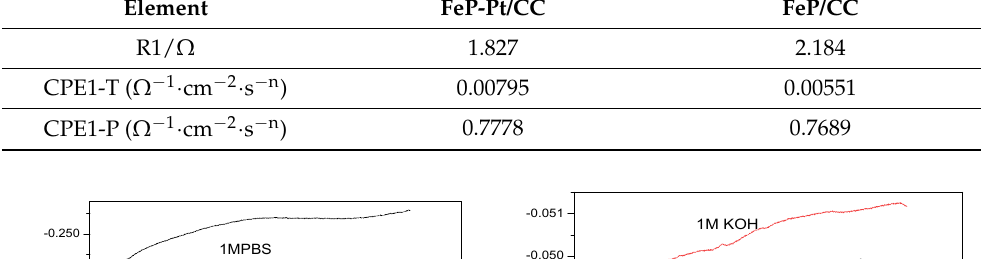
Figure 7. Nyquist plots of FeP-Pt/CC and FeP/CC at − 0.2 V in 1 M KOH. The inset is the equivalent electrical circuit. Table 2. Element values in the equivalent circuit of AC impedance spectrum in 1 M KOH.